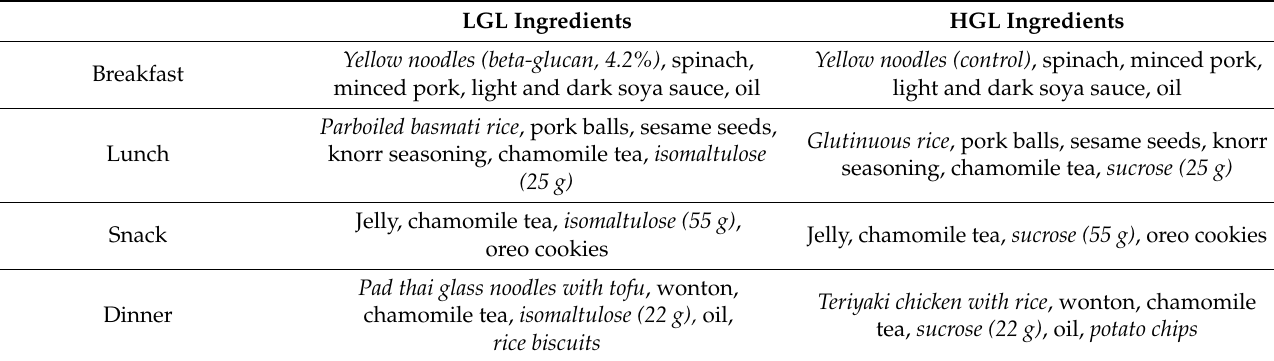
Table 2. Foods used to construct the test meals provided in the